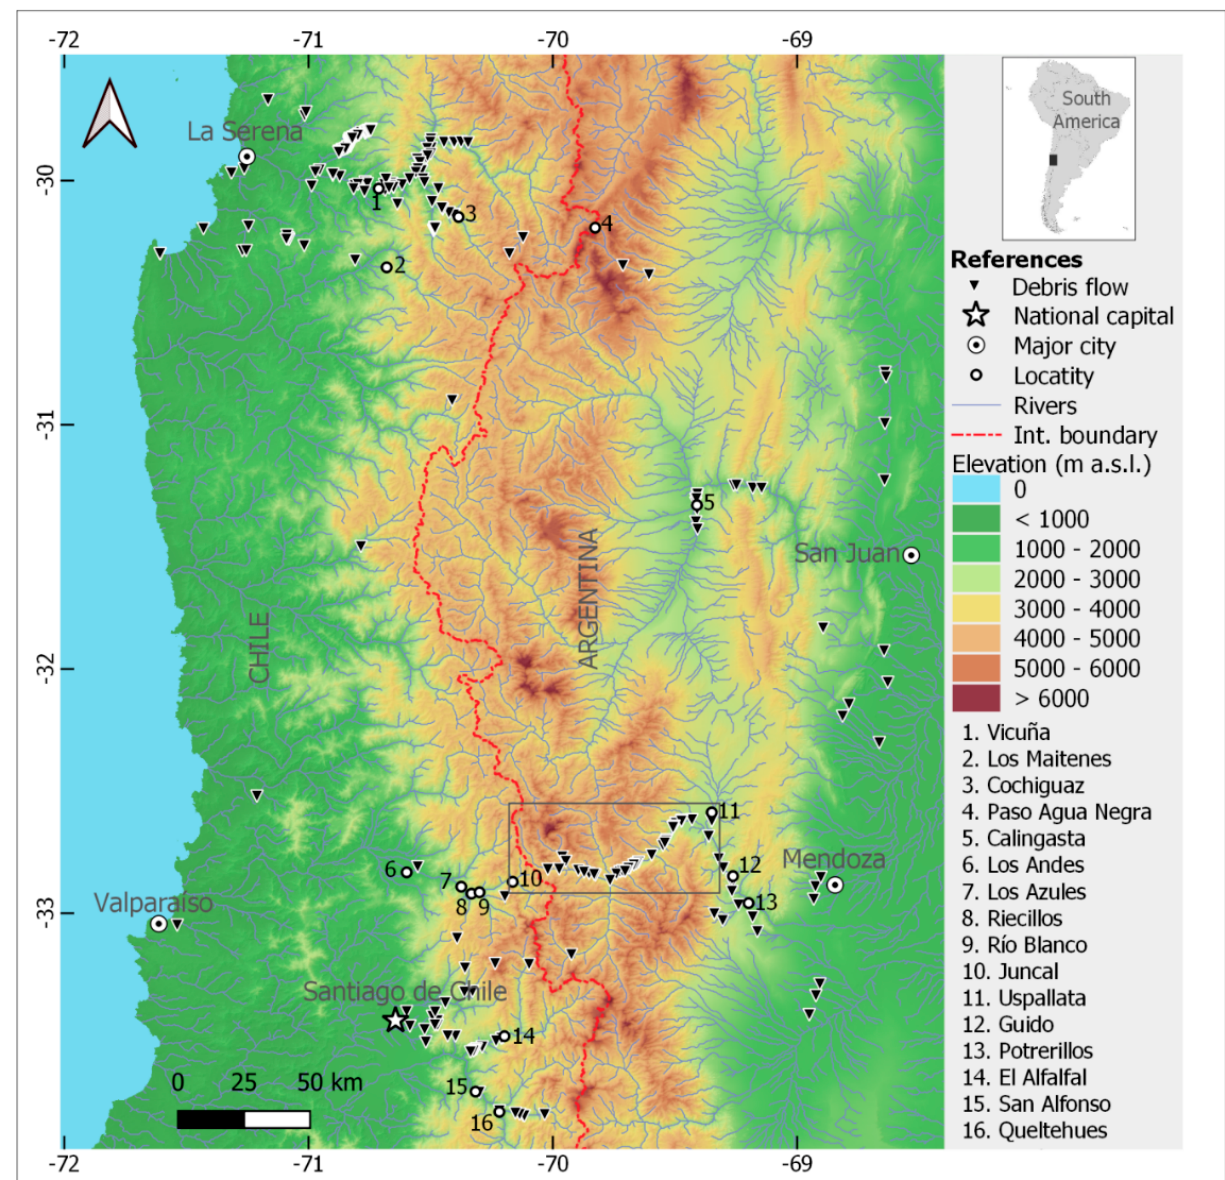
Figure 3. Historical debris flows recorded in the study area (30°–33° S) mainly in villages and along the mountain corridors. Rectangle corresponds to the Mendoza River Valley.